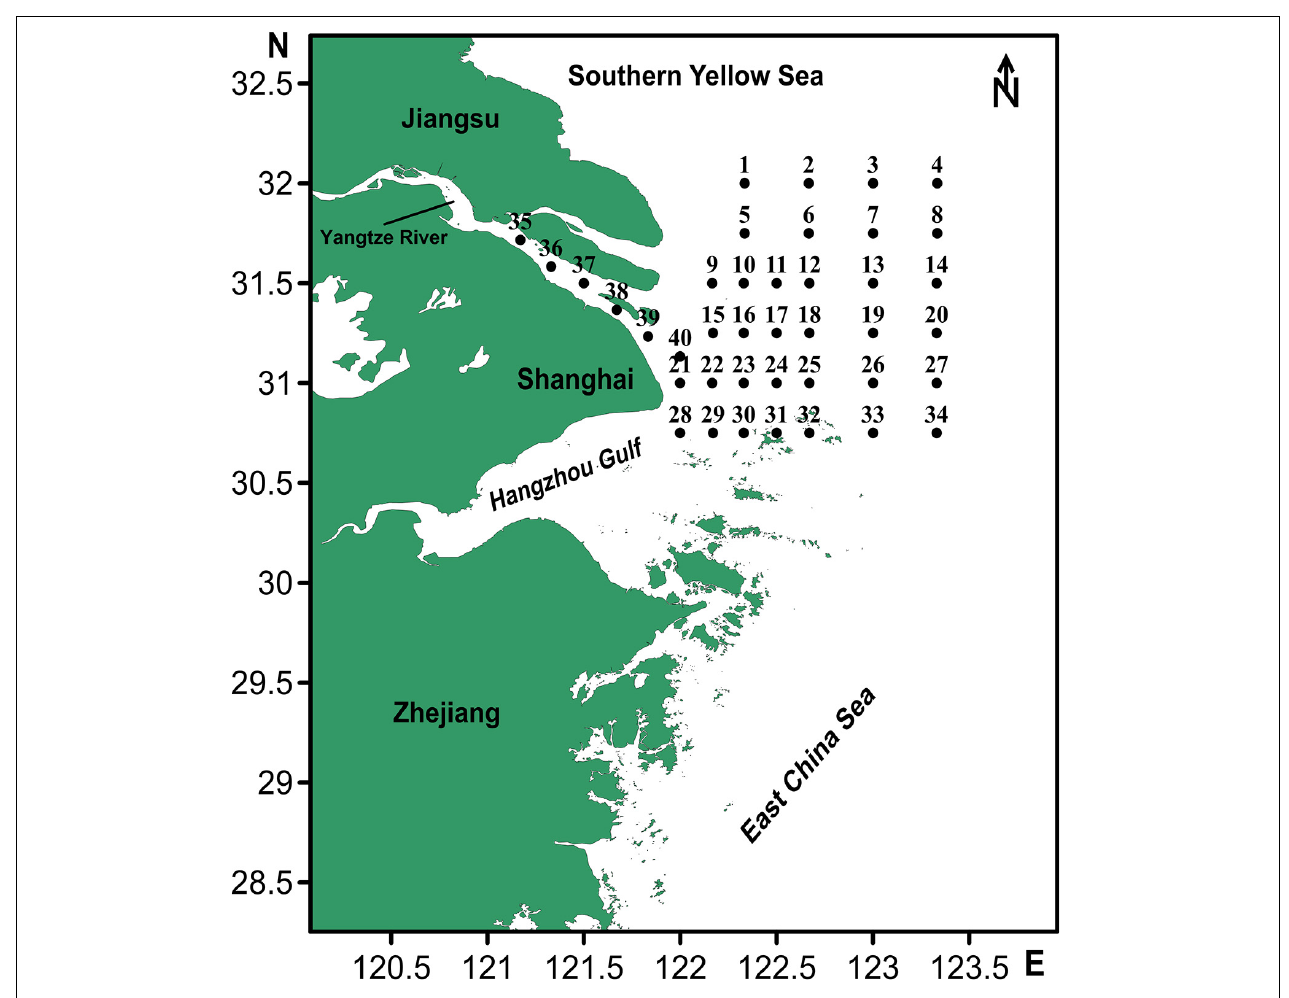
FIGURE 1 | The survey area and sampling sites in the Yangtze estuary and its adjacent waters,